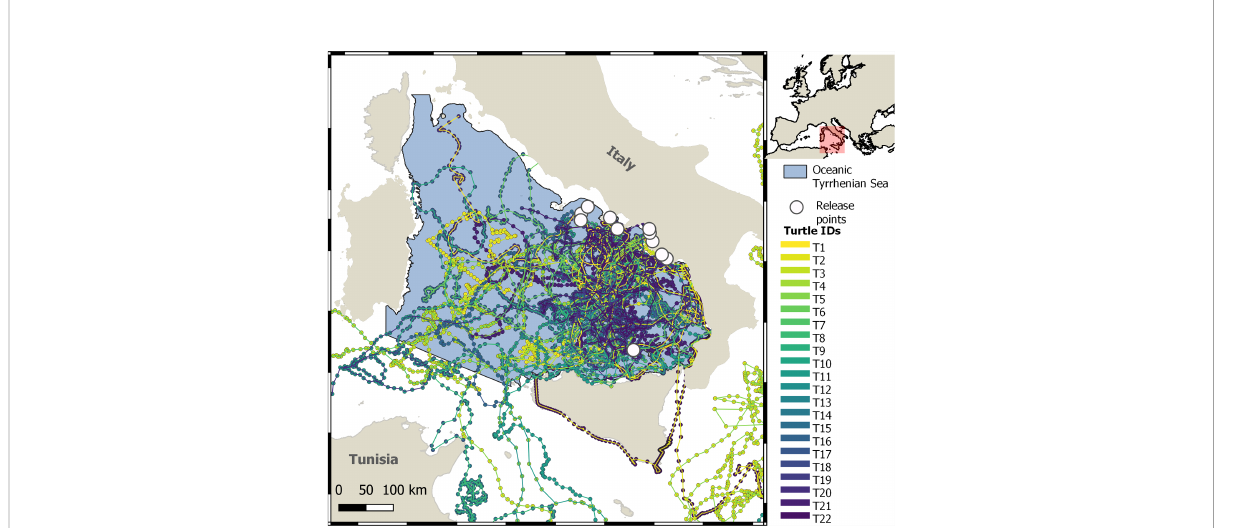
FIGURE 1 Overview of the fi xed-time trajectories of 22 large juvenile and adult loggerhead turtles in the Tyrrhenian Sea, obtained by fi tting the CTCRW model to satellite location